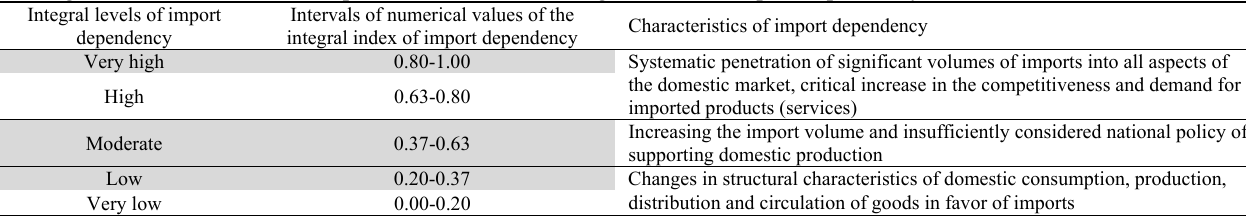
Harrington’s interval scale to interpret the values of the integral index of import dependency Integral levels of import Intervals of numerical values of the dependency integral index of import